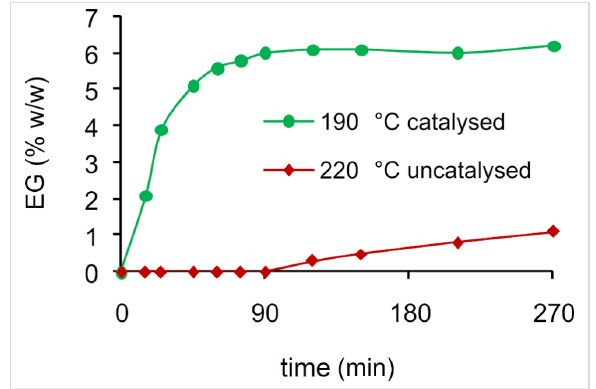
Figure 2: EG produced during glycolytic depolymerisation of PET using DEG + DPG as solvent and titanium(IV) n -butoxide as catalyst. Data from reference